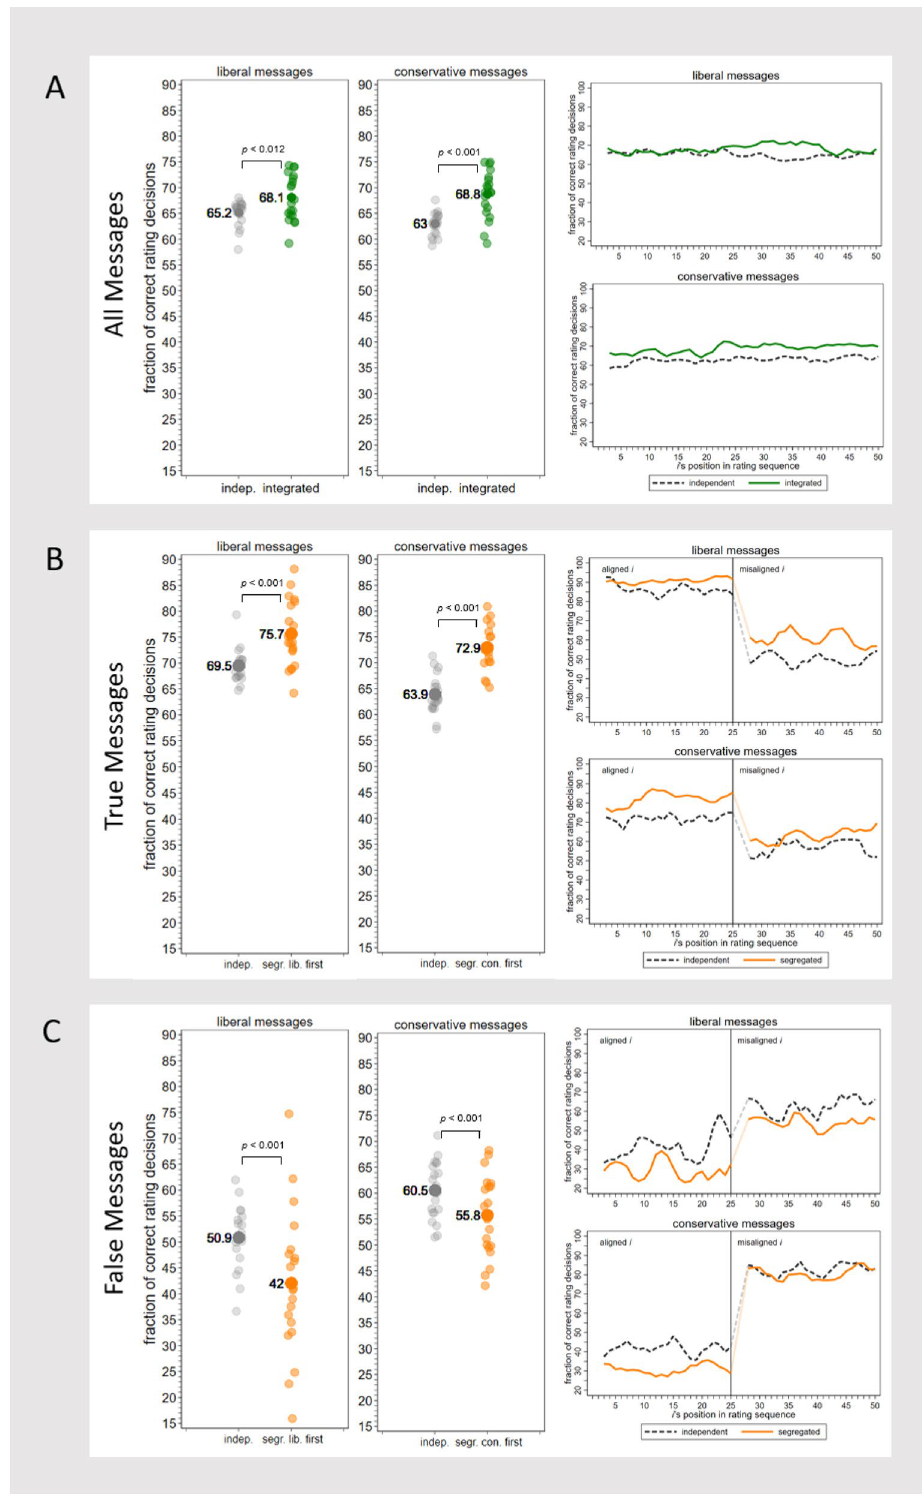
Figure 3. Broadcasting ratings enhances subjects’ rating accuracy in ideologically integrated groups ( A ) and, when messages are true, also in segregated groups ( B ). Ratings backfire in ideologically segregated groups when messages are false ( C ). Left side of the figure: Each small, shaded circle represents the number of correct rating decisions divided by all rating decisions in one group. Large circles represent means over groups. Right side x i + x i − 1 + x i − 2 of the figure: Lines represent moving averages over three subjects ( x = 3 . For this reason, data for subjects at the start of a sequence is not shown). N subjects = 4000; N groups = 80. All messages with d < 0.5; Panel B: true messages with d aligned < 0.5. Panel C: false messages with d aligned > 0.5. See